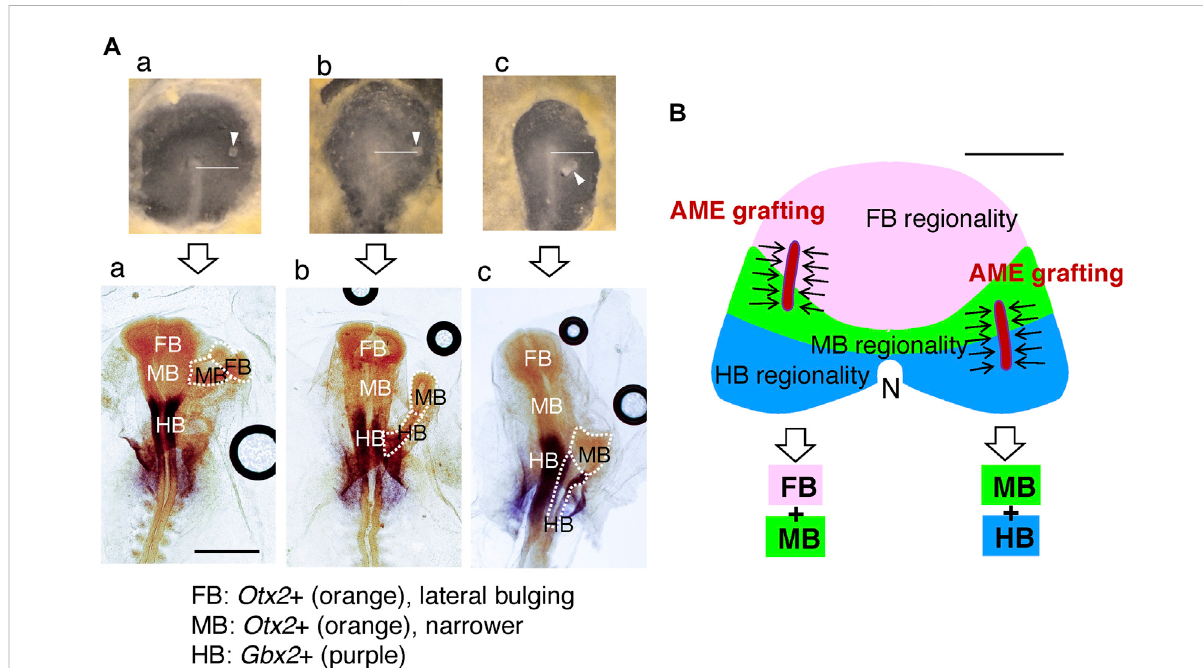
FIGURE 6 The brain portions that developed in the secondary brain depended on the AME graft positions. (A) Representative AME grafts at different AP levels in host embryos immediately after grafting (upper) and after ~18 h with hybridization for Otx2 and Gbx2 (lower). The AME extended anteriorly fromthegraftsitetoalengthof~500 µM. (a) AnexampleofananteriorAMEgraftresultinginFBandMBdevelopmentinthesecondarybrain. (b) The AMEgraftatthenodelevelresultedinMBandHBportionsinthesecondarybrain. (c) PosteriorAMEgraftingelicitedthedevelopmentofinferior MBandlargeHBportions.Inallcases,theposteriorendofthesecondarybrainfusedtothehostbrainatthelevelofthesameportion,supportingthe model that host and secondary brain portions develop using the pool of anterior epiblast cells of the same brain portion speci fi city. The horizontal bars in the upper panels extend 1 mm from the node center. Scale bar for the lower panels, 1 mm. Modi fi ed from Figure 6 of Yoshihi et al. (2022). (B) Upper: Divisions of the anterior epiblast fi eld with distinct brain portion speci fi cities, drawn according to the data in Figure 3C, and the schematic representationoftheextendedAMEgraftsgatheringtheproximalepiblastcells(arrows)fromdifferentdivisions.Lower:Theresultantcompositionof the brain portions in the secondary brain. These relationships were con fi rmed using 13 AME-grafted embryos. Two additional FB-only examples are shown in Figure 7. The host brain on the midline develops with all three FB, MB, and HB portions, because the midline AME passes through all three epiblast divisions. Scale bar, 500